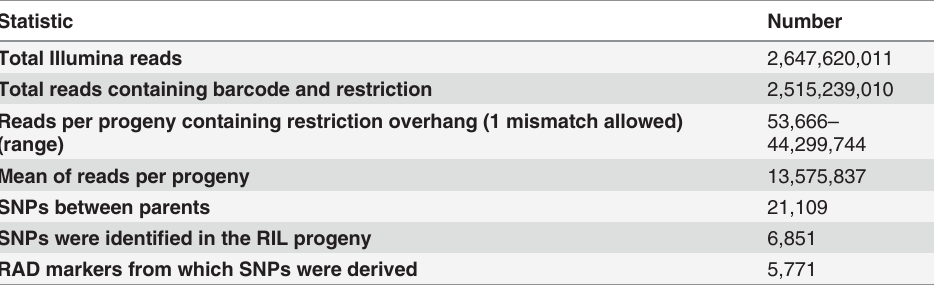
Table 1. RAD-seq statistics summary of two-enzyme library from parents and their RIL progeny.